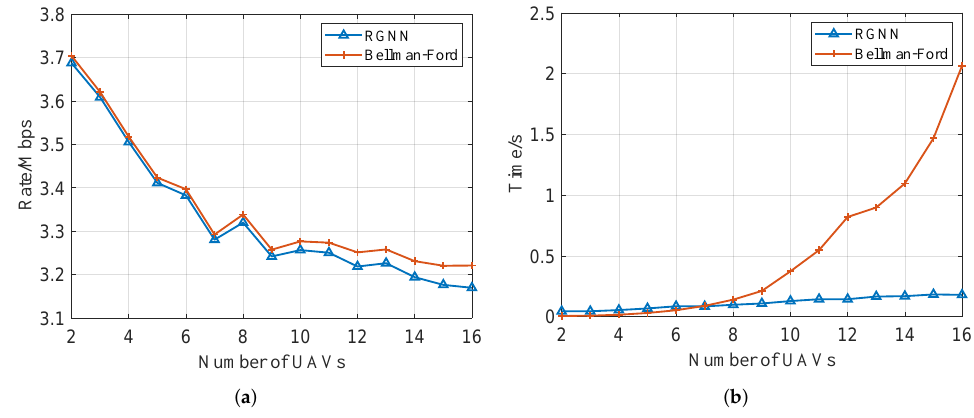
Figure 5. The relation of |V u | on communication rate and computation time for different algorithms. ( a ) The relation of |V u | on communication rate. ( b ) The relation of |V u | on computation